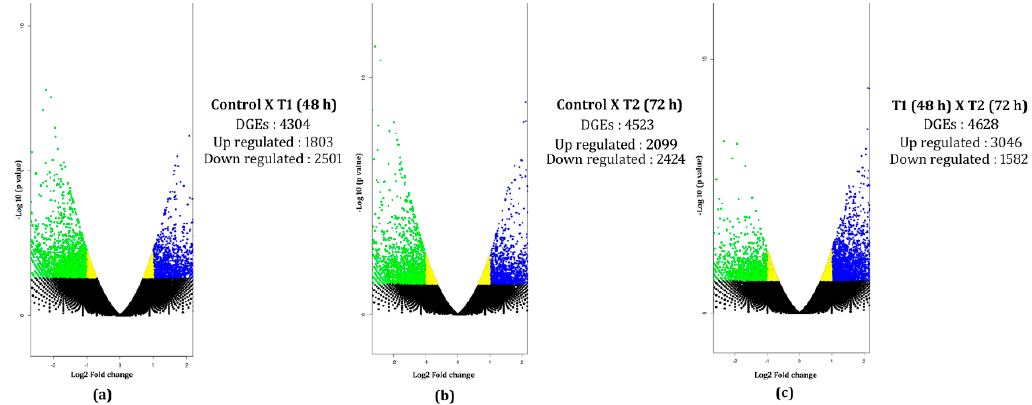
Figure 9. Volcano plots for the DEGs under different PEG treatments. Volcano plot DEGs generated for: ( a ) control (no drought) vs. T1 (48 h PEG treatment); ( b ) control (no drought) vs. T2 (72 h PEG treatment); ( c ) T1 (48 h PEG treatment) vs. T2 (72 h PEG treatment). The X and Y axis denote the log 2-fold change and -log10 (p-value), respectively. The blue dots represent upregulated genes, green represents downregulated, black represents the neutrally regulated.